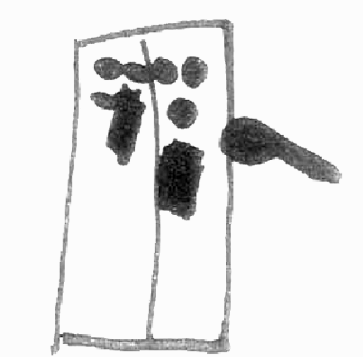
Figura 3. A igualiza(cid:231)ªo das parcelas 3 e